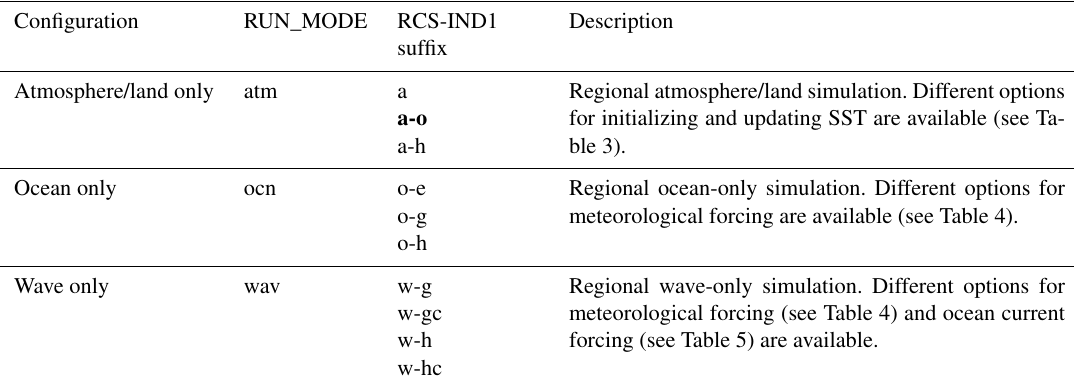
Partially coupled ocean–wave simulation. Different meteoro- logical forcing data selected as “g” or “h” options (see Table 3). Table 2. Summary of the RCS-IND1 uncoupled configurations available in the RCS, and naming conventions used in this paper. Results from configuration names in bold are demonstrated in this paper. Options are controlled in the RCS using the RUN_MODE environment variable. See also Fig. 2.